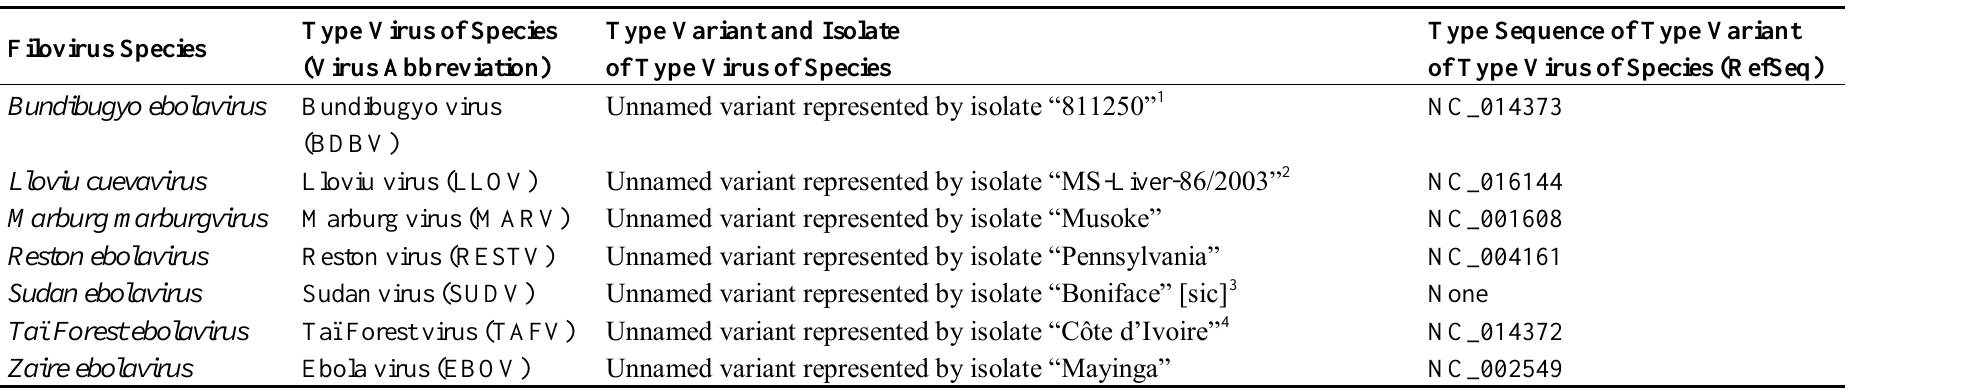
Table 2. Temporary filovirus type viruses and type variants chosen by the 2010-2011 ICTV Filoviridae Study Group [27], and filovirus type sequences available from